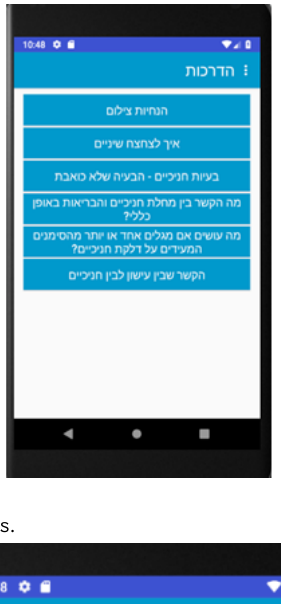
Figure 11. Tutorial screen for the patient: main.